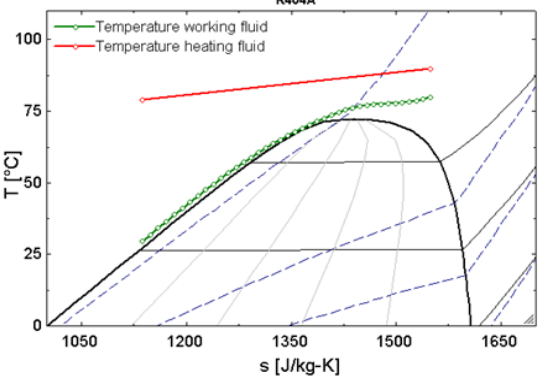
Figure 1. T , s -diagram of the heating process in the supercritical heat exchanger.